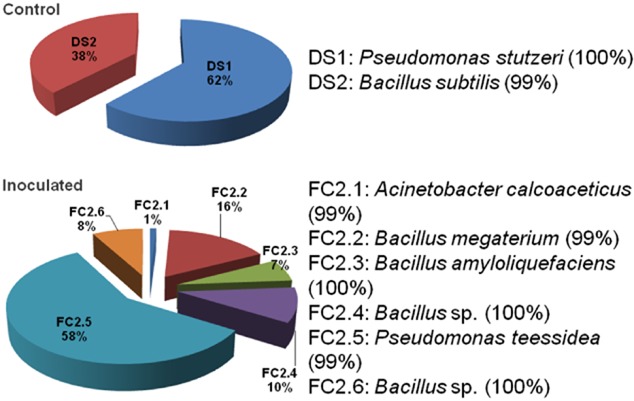
The levels of presence frequence (expressed as percentage per total culturable colonies) of the bacterial isolates from an inoculated MFC and the control. Isolation was done on solid Winogradsky medium. Isolates named with ‘DS’ were from the control, while those named with ‘FC2’ were from an inoculated MFC. Notes on the right indicate the proposed taxonomic identification of the corresponding isolates based on observations of their cell and colony morphology and analyses of their 16S rDNA sequences. The percentage of similarity between the 16S rDNA sequence of an isolate and that of the proposed species was shown in the brackets next to the corresponding note.